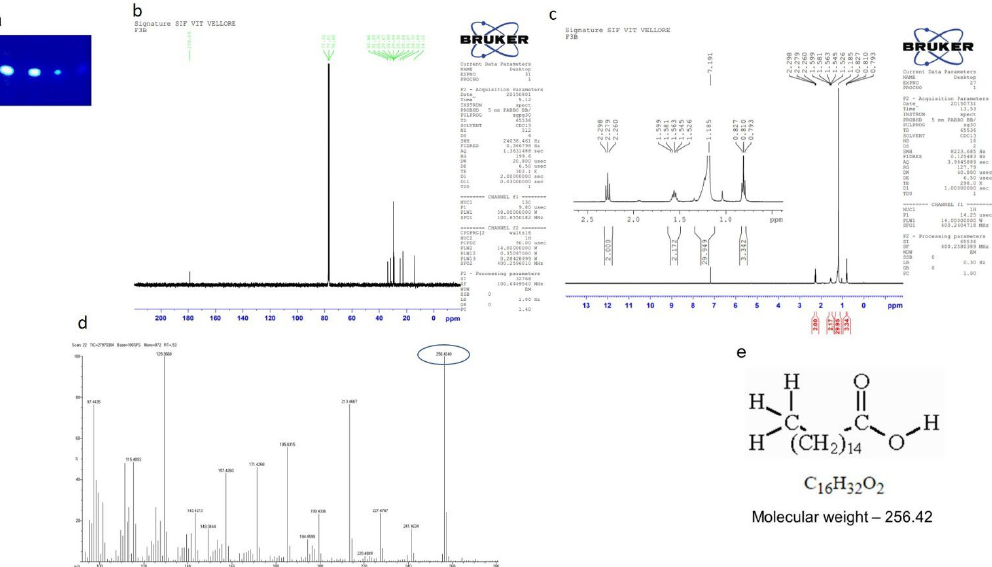
Figure 7. Isolation of compound 2 (Hexadecanoic acid). ( a ) TLC showing a single spot of compound eluted at petroleum ether:ethyl acetate (8:2), ( b ) 13 C NMR, ( c ) 1 H NMR, ( d ) HRMS, ( e ) molecular weight and structure.